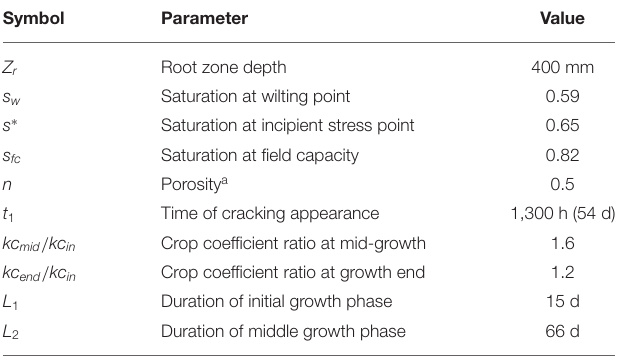
TABLE 2 | List of constant parameters used for modeling soil moisture